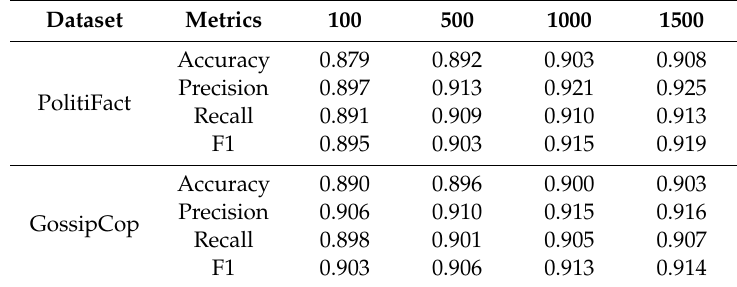
Table 3. Performance of our approach on the partial datasets.